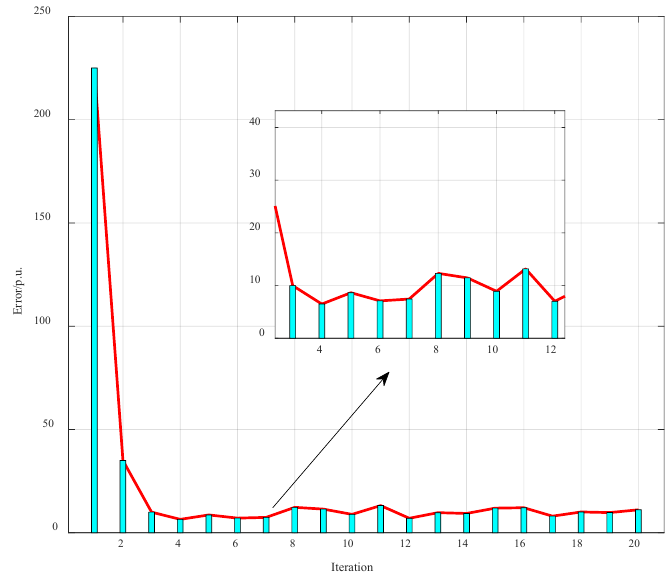
Figure 5. Iterative error in power flow calculation process.